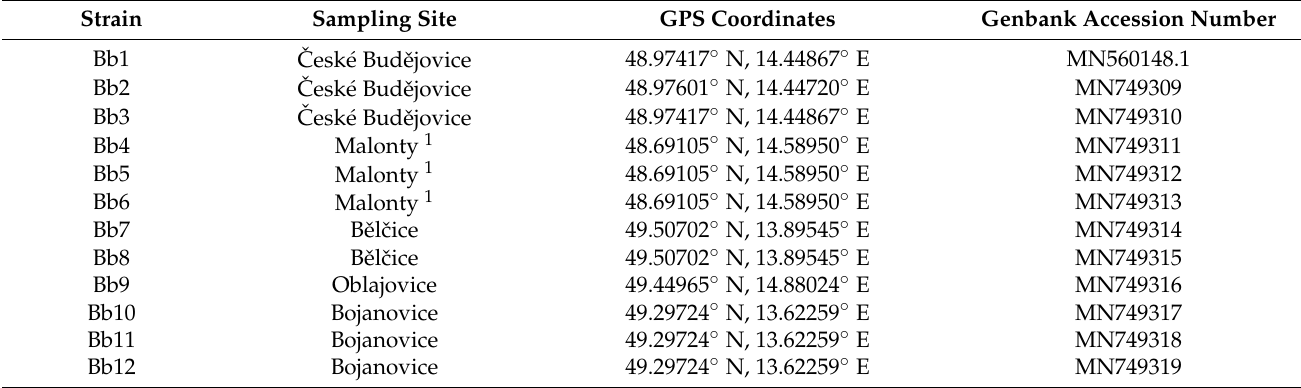
Table 1. Strains of Beauveria bassiana isolated within this study and used in